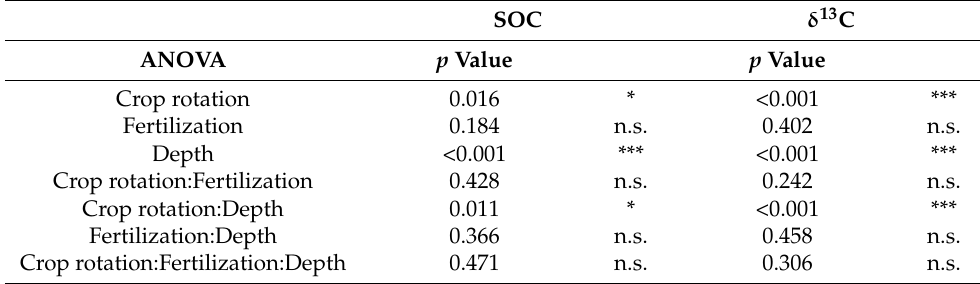
Table 2. Isotope delta values of soil organic carbon in the 0–30 cm layer of CR6 (50% maize) and CR10 (no maize) in three different years after the start of the experiment in 2004. Fertilized treat ‐ ments received biogas digestate. Different uppercase letters represent significant differences be ‐ tween crop rotations in a specific year and different lowercase letters represent significant differ ‐ ences between years in a specific crop rotation, both at a significance level of p < 0.05. Due to no significant effect or interaction of fertilization, data were pooled over fertilizer treatments prior to comparisons of means.